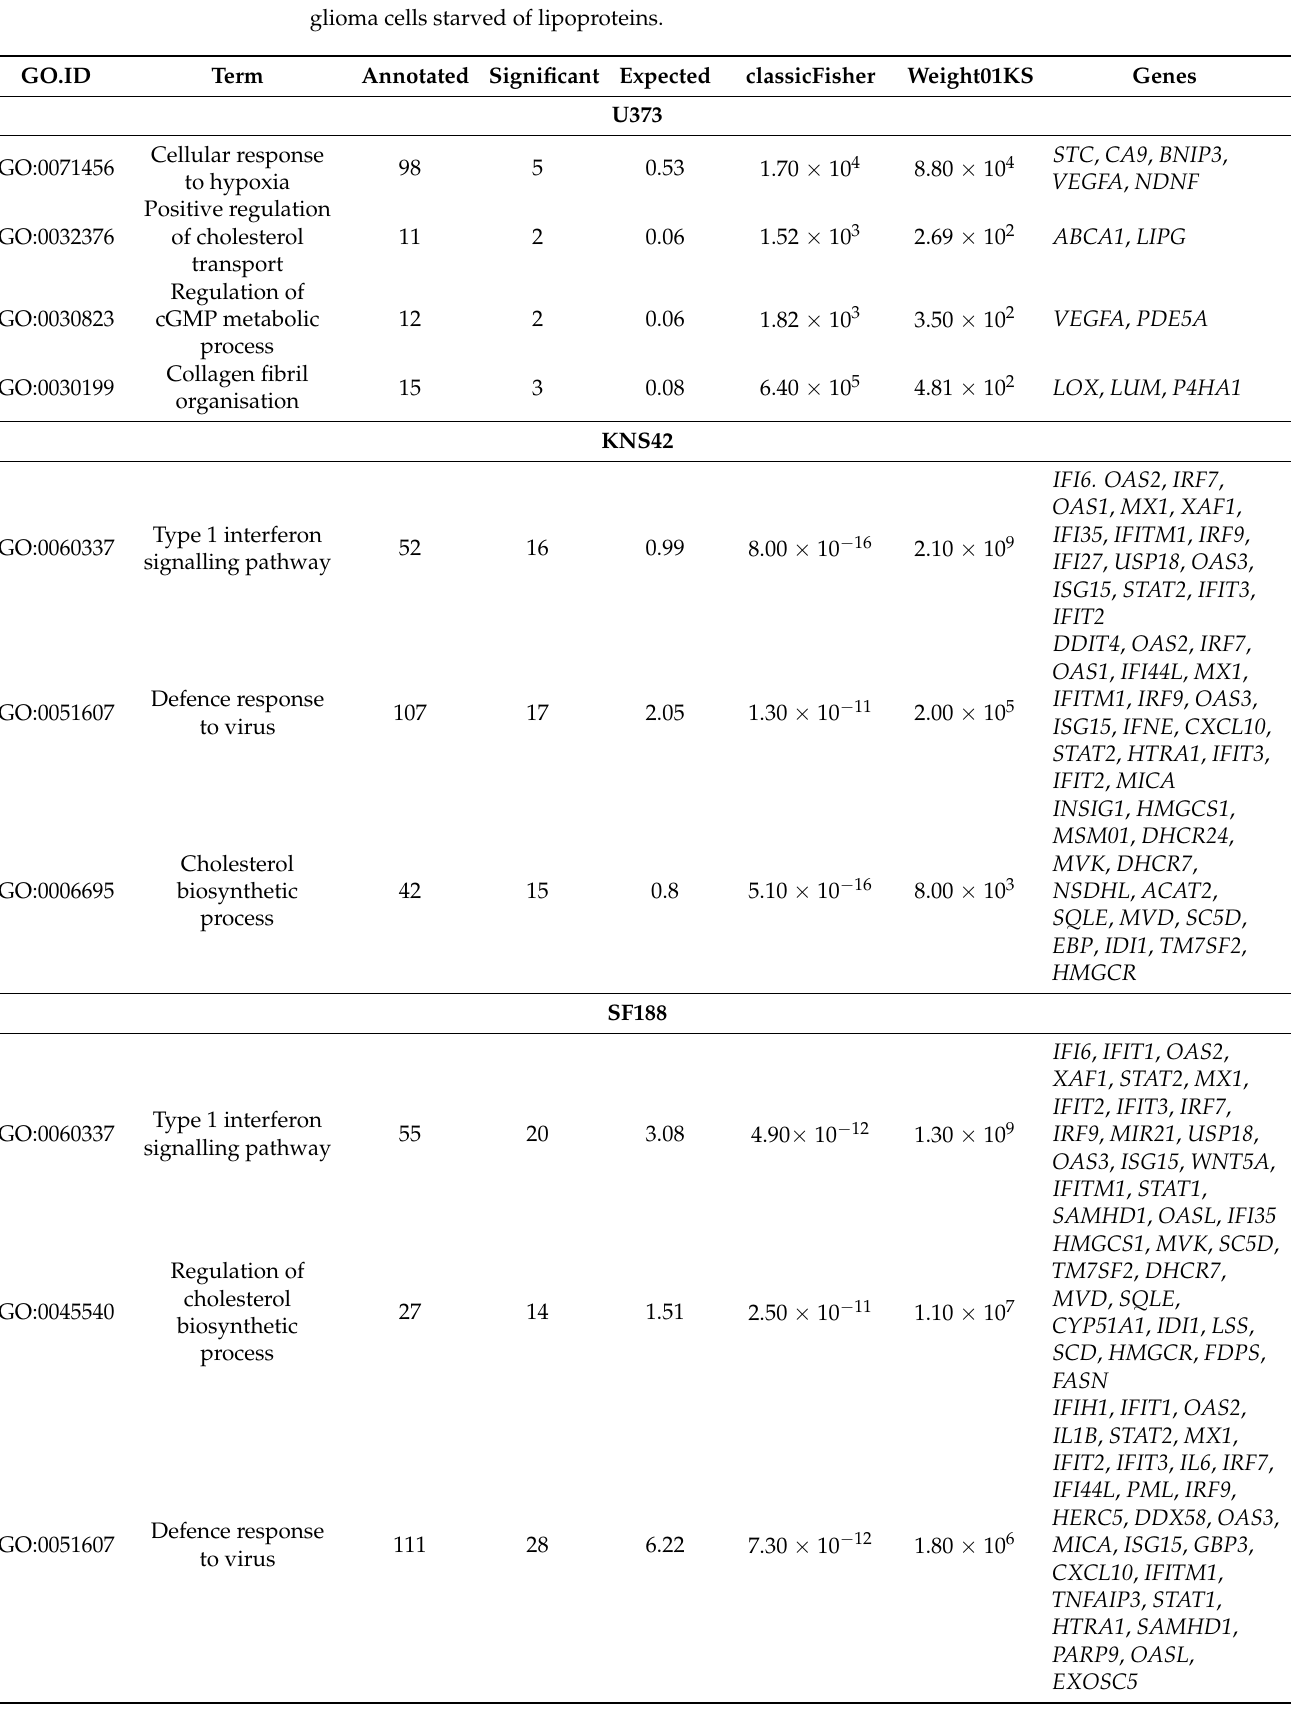
Table 1. Gene ontology analysis of differentially expressed genes in U373, KNS42 and SF188 diffuse glioma cells starved of